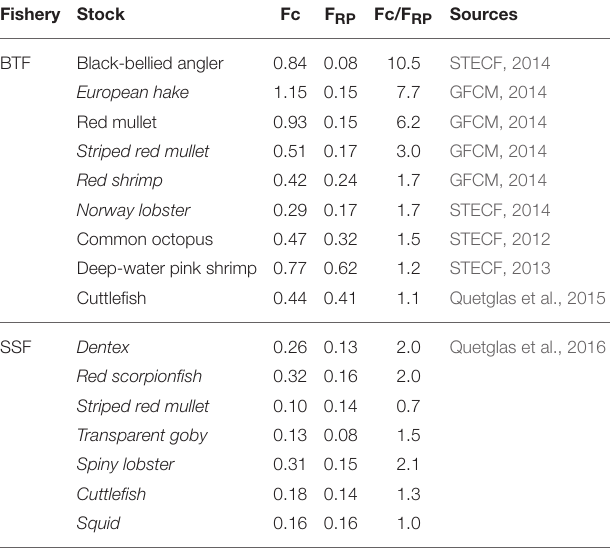
TABLE 1 | Stock status indicators of demersal species taken by the bottom trawl (BTF) and small-scale (SSF) fisheries from the Balearic Islands showing the current fishing mortality (F c ), the reference biological point (F RP : F 0.1 for BTF, F MSY for SSF), the ratio between them (F c /F RP ), and the information